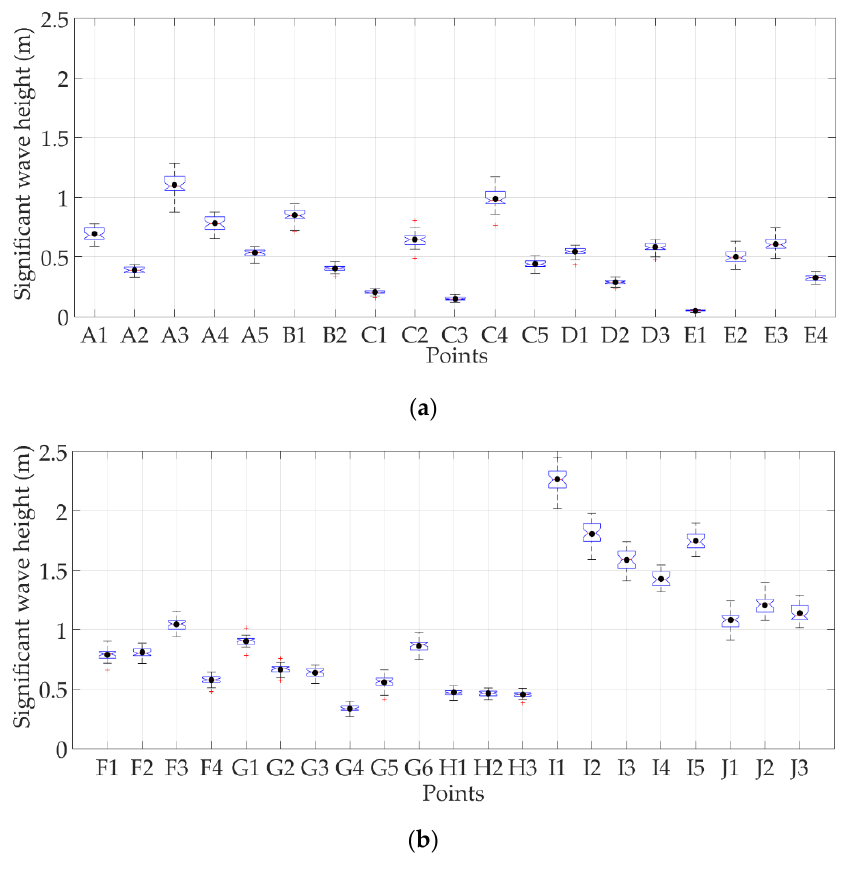
Figure 6. Assessment of the yearly mean significant wave height corresponding to the 35-year time slice (corresponding to the time interval 1983–2017) resulting from processing the ECMWF ERA-Interim data. Each box includes several keys: the top and the bottom of the box represent the upper and lower quartiles, so the box spans the interquartile range; the median is marked by a vertical red line placed inside of the box; the whiskers are the lines (two) outside the box that extend to the highest (upper extreme) and lowest (lower extreme) observations; the outliers are those observations that are numerically distant from the rest. ( a ) Reference points A–E; ( b ) Reference points F–J.